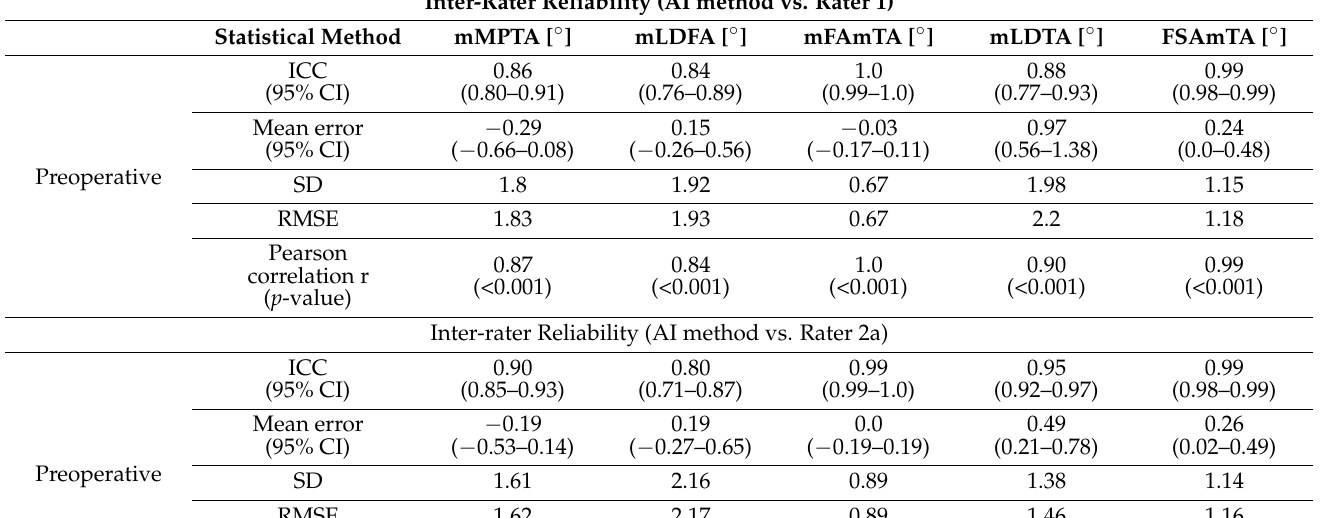
Table 3. Inter-rater reliability between AI method and manual measurements; preoperative n = 94 for mMPTA, mLDTA, FSAmTA, n = 88 for mLDFA, mFAmTA; postoperative n = 102 for mMPTA, mLDTA, n = 100 for FSAmTA, n = 99 for mLDFA, n = 97 for mFAmTA. Inter-Rater Reliability (AI method vs. Rater